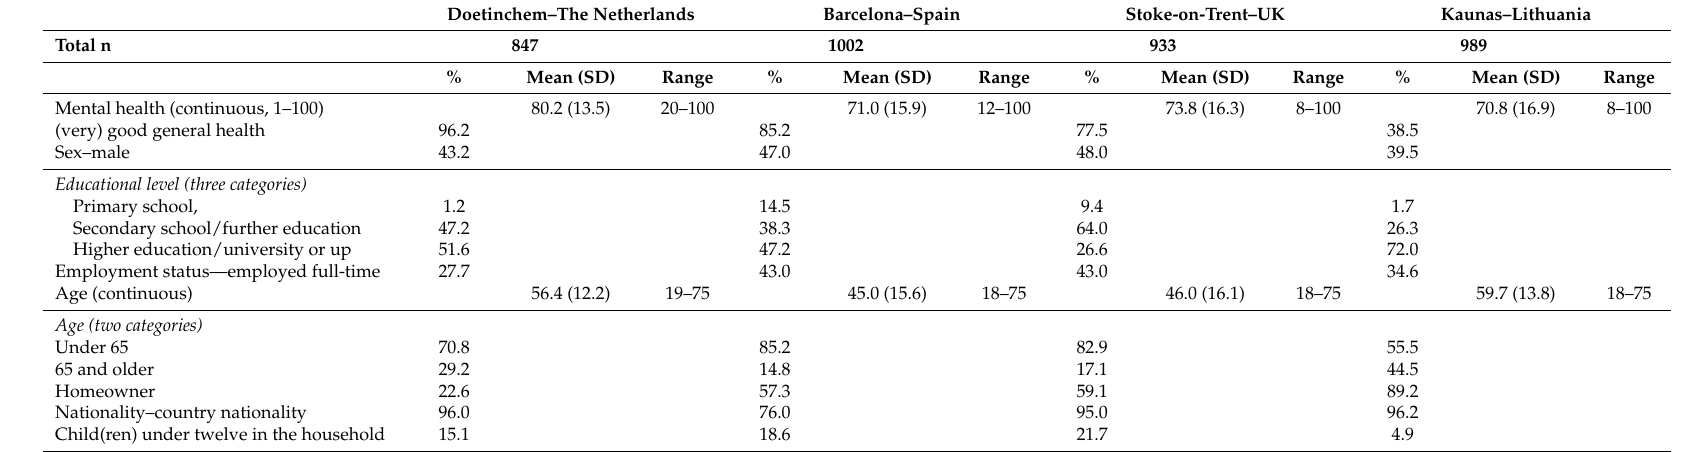
Table 2. Descriptive statistics of the respondents by